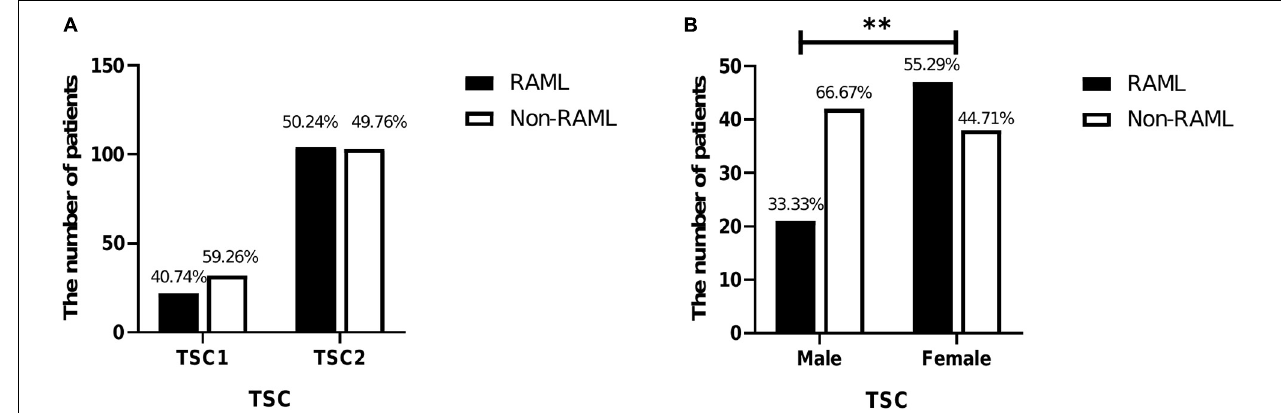
FIGURE 1 | Characteristics of 261 patients included in this study. (A) Comparison of TSC1 and TSC2 mutations in RAML and non-RAML patients. (B) Comparison of genders in RAML and non-RAML of TSC patients; ∗∗ p <